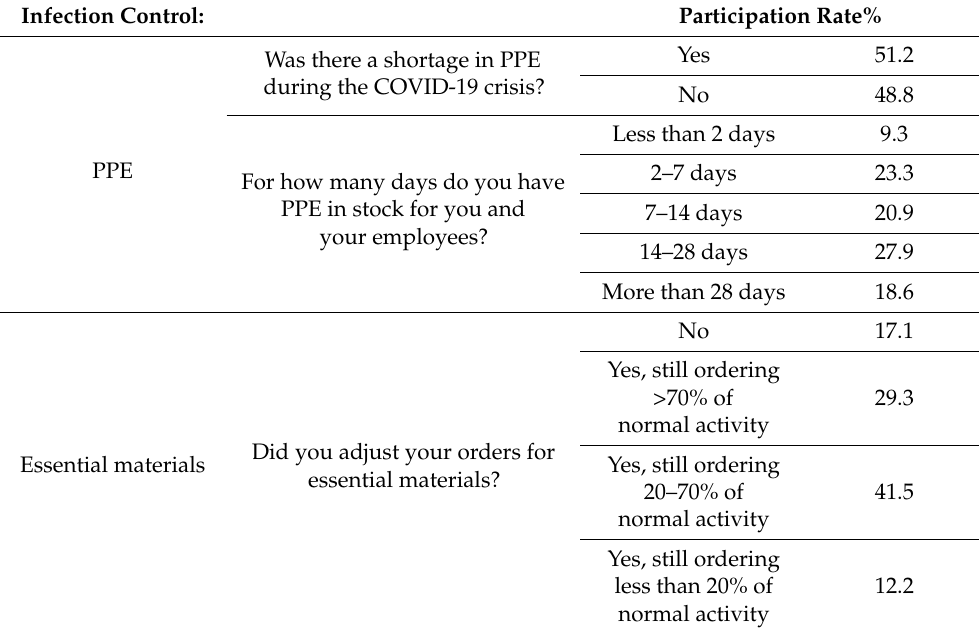
Figure 7. Radiology workers who infected with COVID-19. Table 4. PPE shortage, stock, and ordering of essential materials in radiology departments.